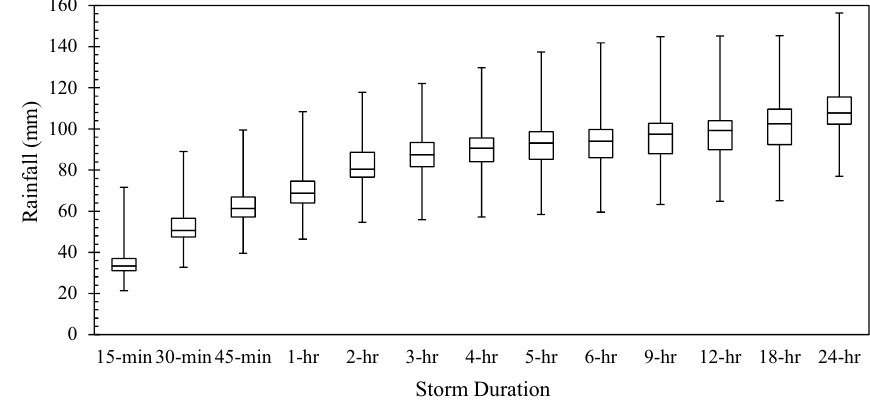
Fig. 1 Box plot of the rainfall values of various